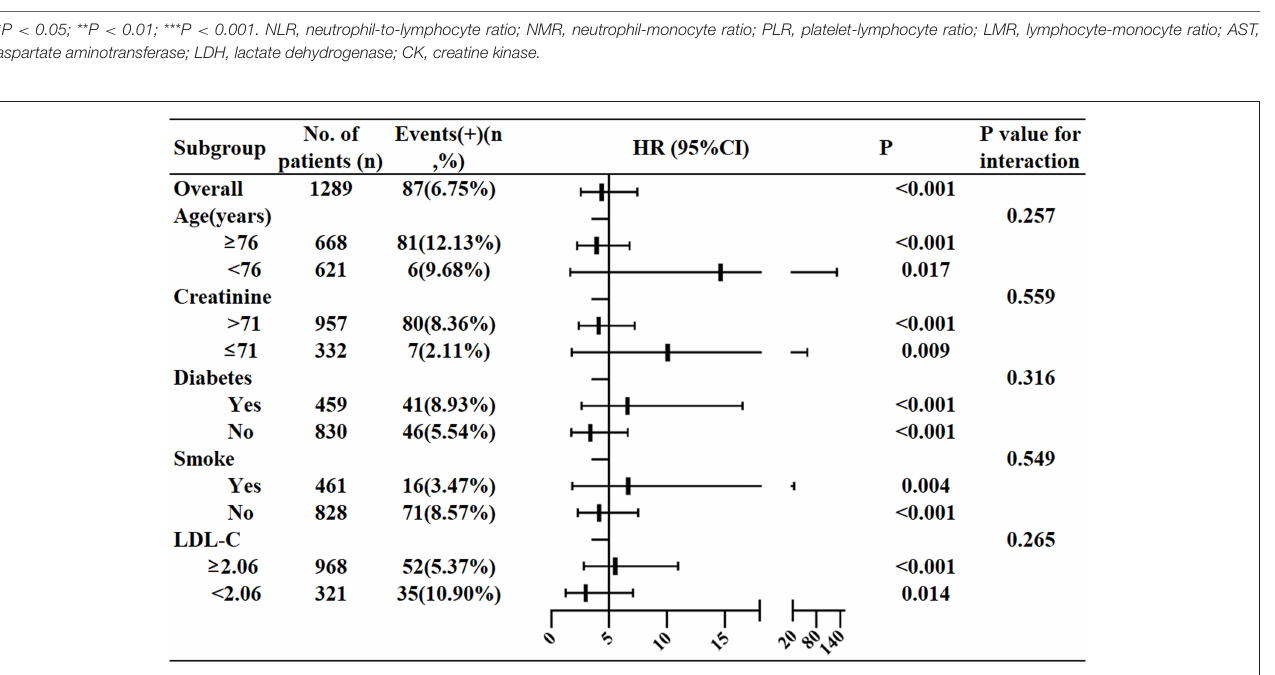
NMR, PLR, and LMR) in NSTEMI and STEMI. We